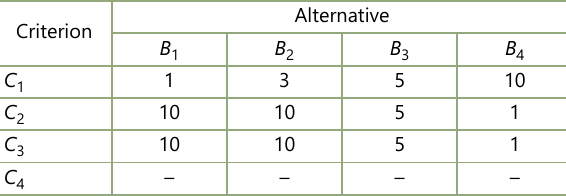
Table 11. Assessment of offers of transport options with the use of weighted point method (source: own contribution)